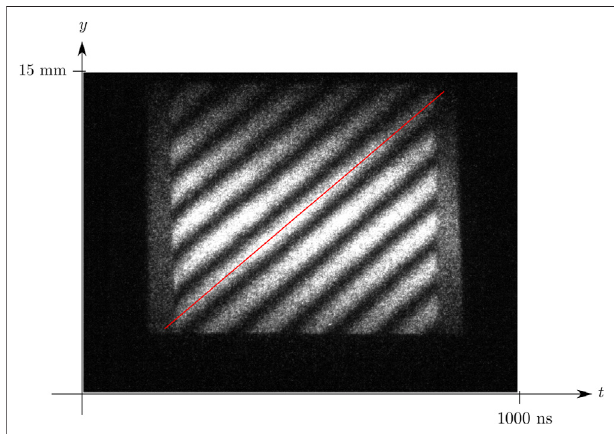
FIGURE 7 | Straight line superimposed on the interference fringes shown in Figure 4